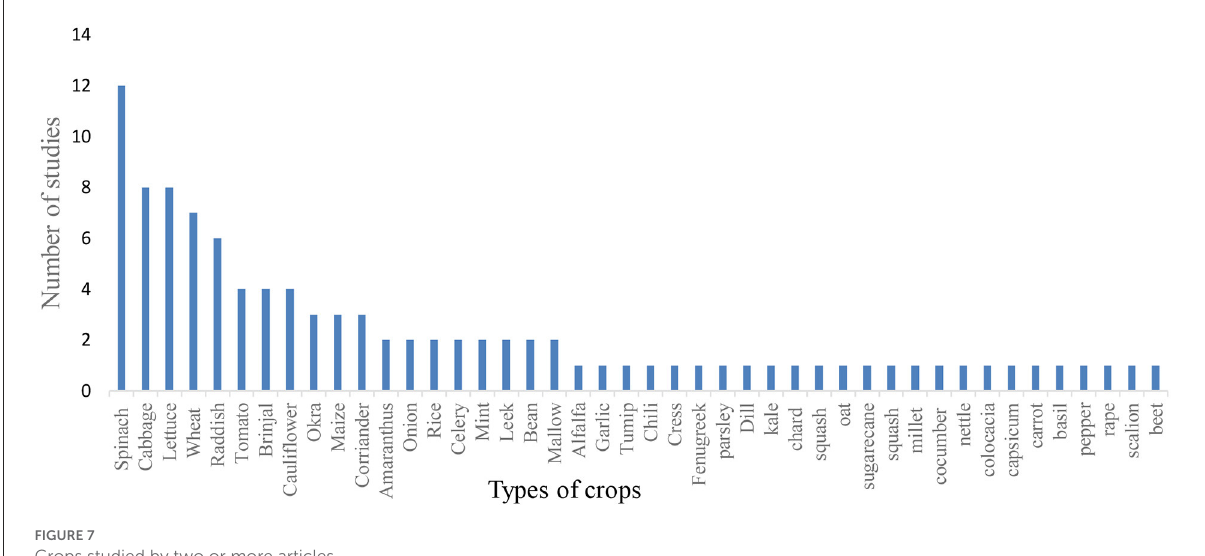
FIGURE7 Crops studied by two or more